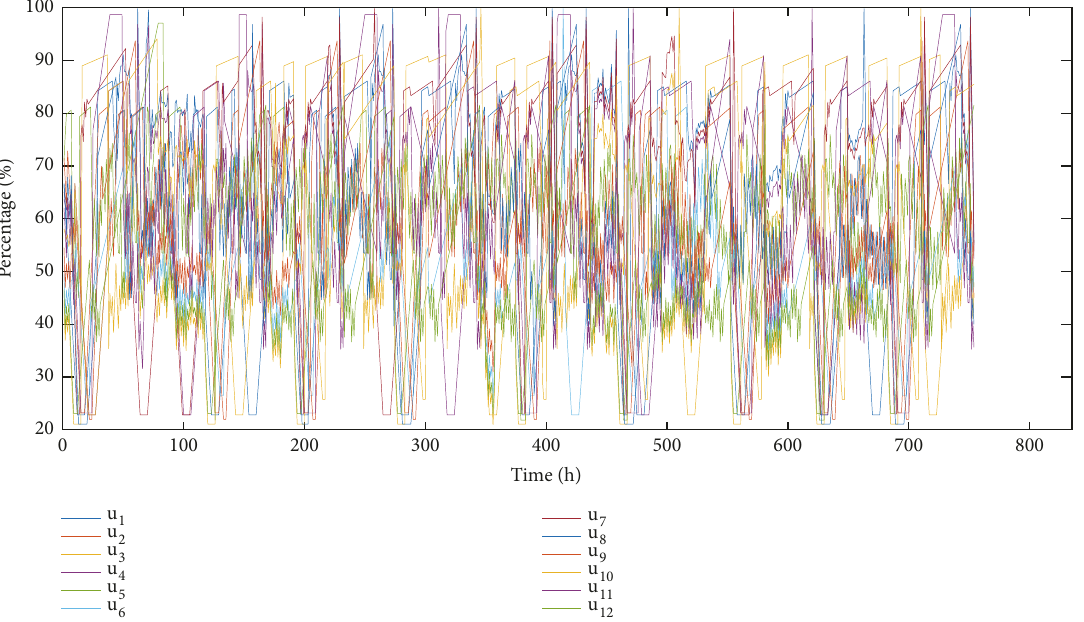
Figure 18: All inputs of the system.